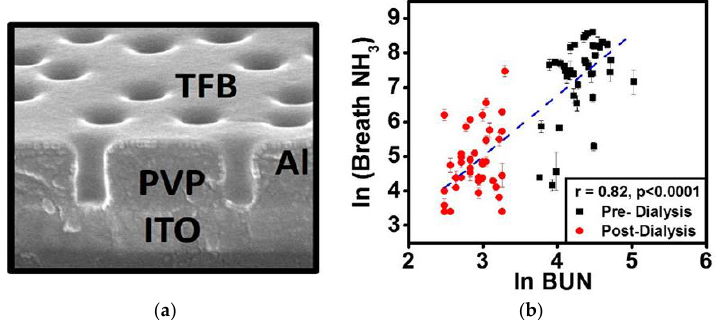
Figure 9. ( a ) Cylindrical nanopore structure of poly[(9,9-dioctylfluorenyl-2,7-diyl)-co-(4,4′-( N -(4-s- butylphenyl))diphenylamine)] (TFB) sensing material; ( b ) Analysis of the breath profile of patients before and after dialysis. Reprinted from [67].